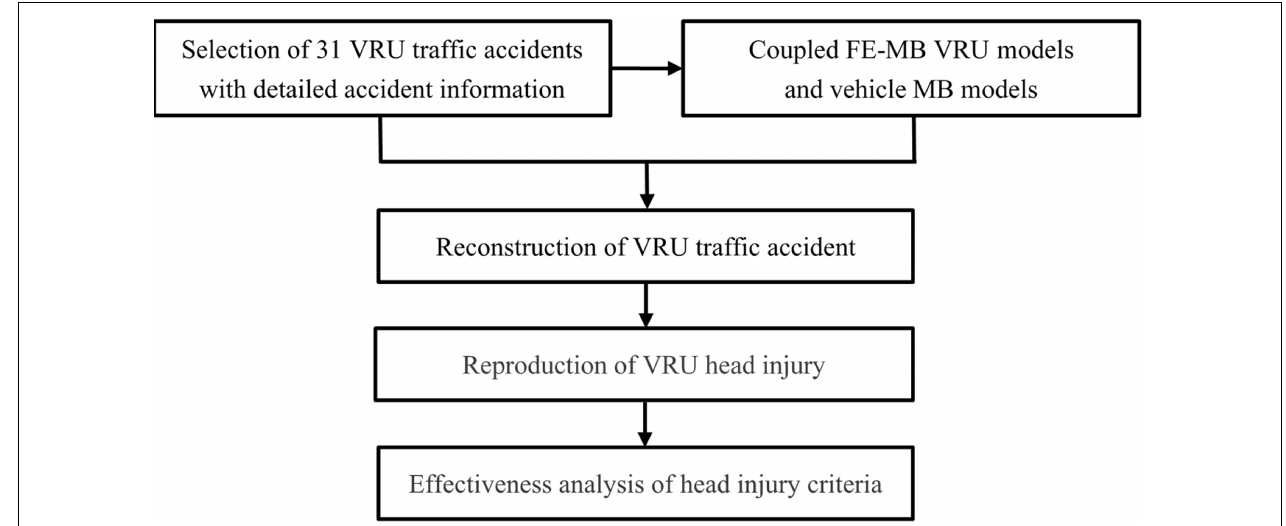
FIGURE 1 | Schematic of the research